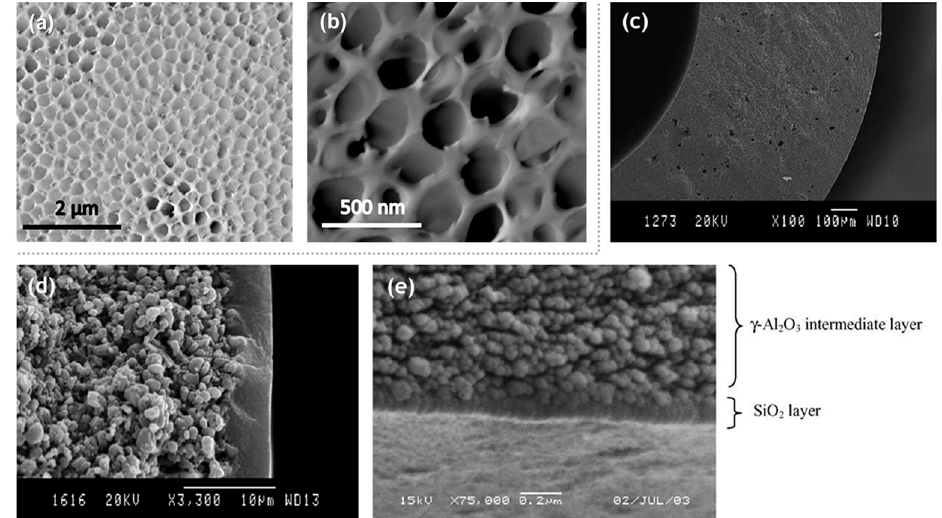
Figure 8. Top-view SEM images of ( a ) anodic aluminum oxide support coated with silica film (70 nm thick) after calcination and ( b ) anodic aluminum oxide support coated with silica film (70 nm thick) after calcination and several minutes of SEM exposure. Adapted from [87], with permission from Copyright (2016), American Chemical Society. SEM micrographs of the various layers constituting the membrane: ( c ) cross-section substrate (magnification 100×), ( d ) cross-section intermediate γ -Al 2 O 3 layers on top of the substrate (magnification 3300×) and ( e ) cross-section silica membrane on the intermediate γ -Al 2 O 3 layers (magnification 75000×). Adapted from [82], with permission from Copyright (2004), Elsevier